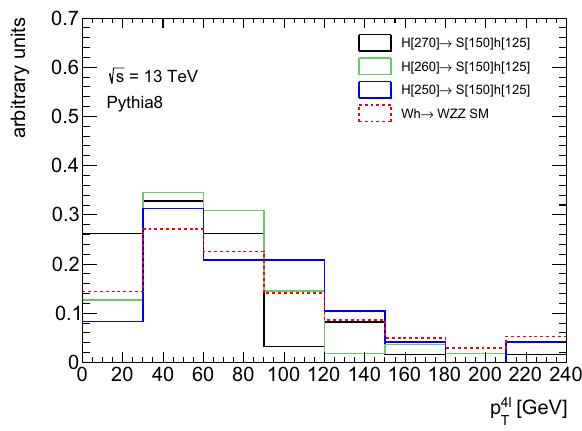
Fig. 11 Transverse momentum of the leptons associated to the SM Higgs decay for the H → Sh samples (solid lines) compared with the SM Wh process with h → Z Z → 4 (cid:4) and W → (cid:4)ν (dashed line) generated with PYTHIA8 . The last bin contains overflow